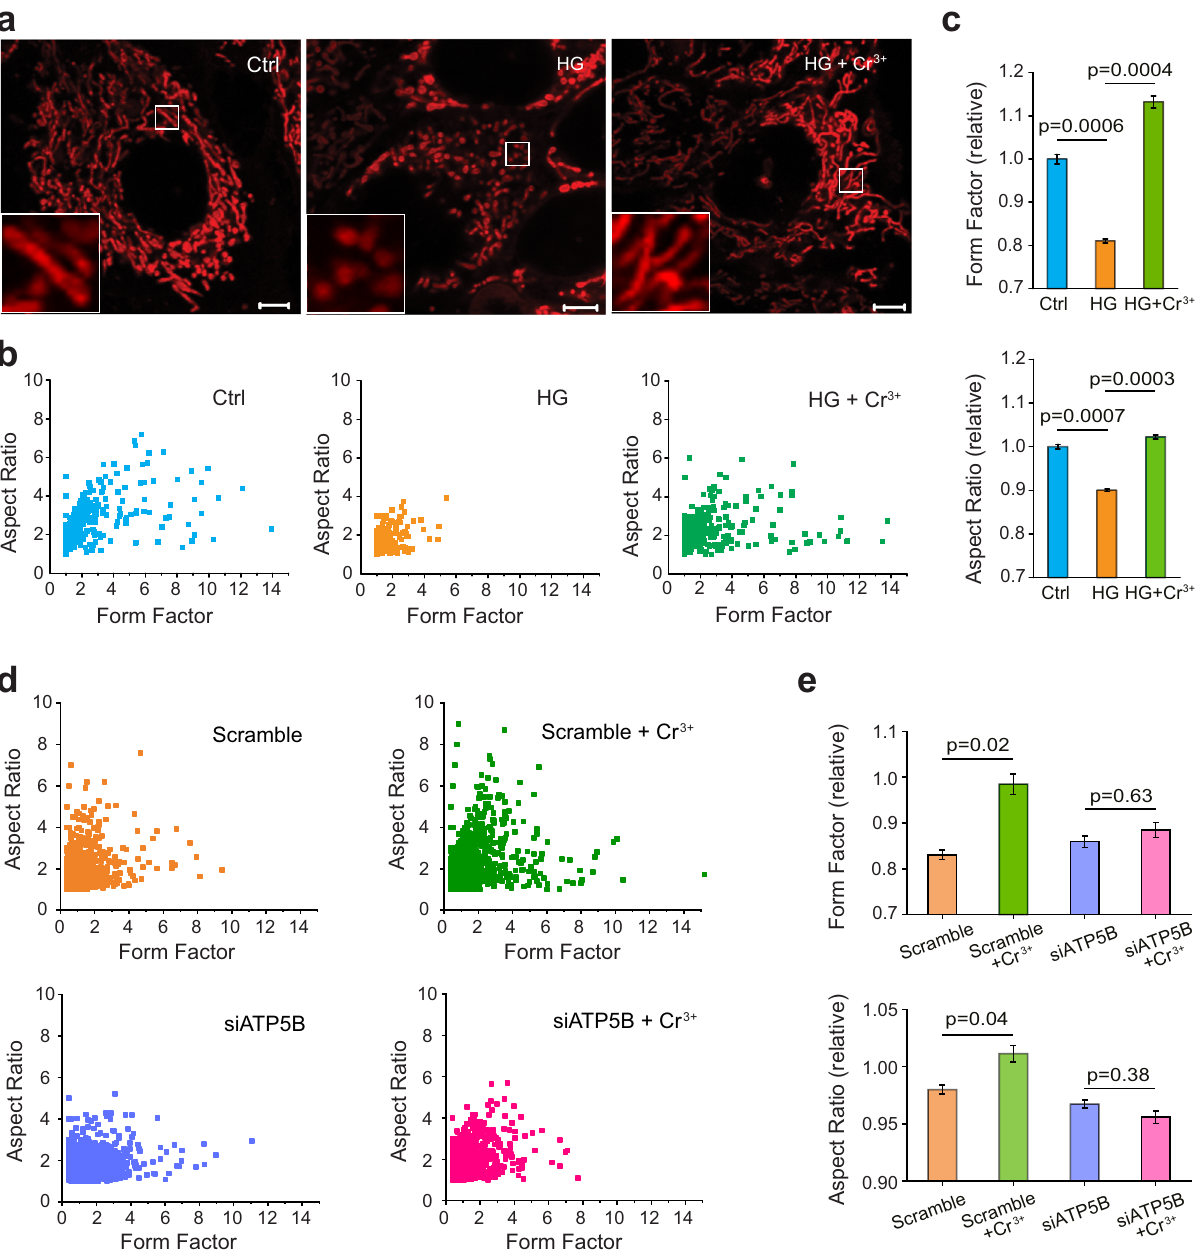
aspect ratio (AR). n =10; mean±SEM. Two-sided Student ’ s t test. d , e Quantitative analysisandquanti fi cationofmitochondrialmorphologyinscrambleorATP5Bnull (siATP5B-transfected) HepG2 cells. n =5; mean±SEM. Two-sided Student ’ s t test. Representative microscopic images are shown in Supplementary Fig. 11. Mito- chondria remains fragmented even when 100 µ M Cr 3+ were supplemented to ATP5B-silenced cells. Individual data points ( c , e ) are available from Source Data, which are provided as a Source Data fi